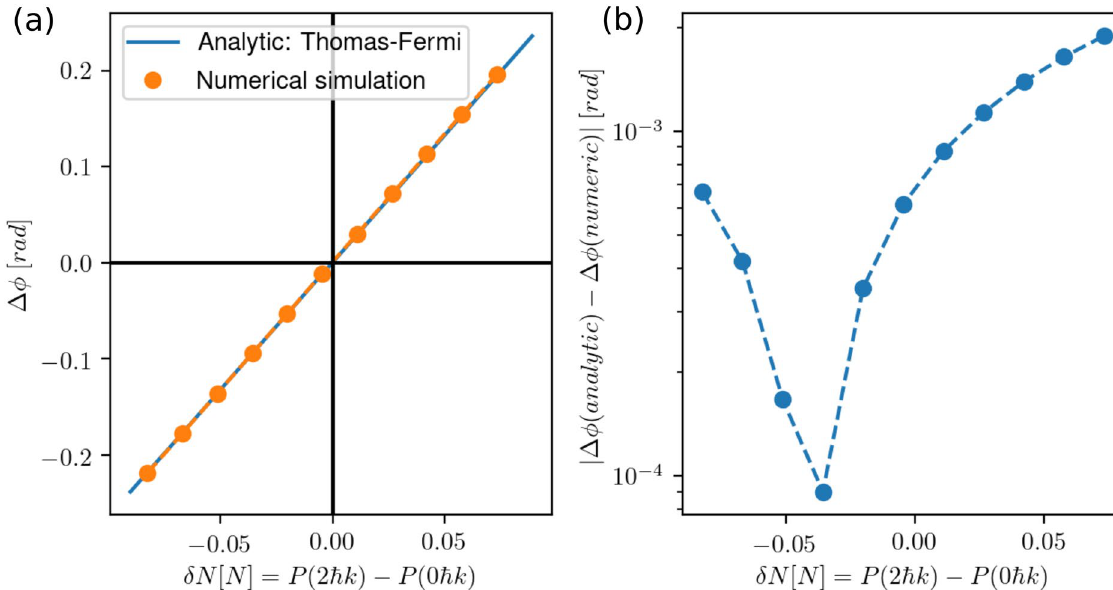
Figure 6. ( a ) Mean-field-driven phase shifts as a function of the particle imbalance δ N . The analytic solution is given by Eq. (24) (blue line). For the numerical solution (orange dots), we modeled the imbalance by considering a first π 2 beam-splitter with a finite fidelity. The Gaussian splitter and mirror pulses have peak Rabi 50 µ s, respectively. The transverse 1.0573 ω 25 µ s and τ frequencies of (cid:31) r with pulse lengths of τ bs = m = = 50 Hz and the initial trap frequency in which trapping frequency is realised with an angular frequency of 2 π × 1 Hz with a number of atoms of N 6 10 4 and a scattering length of the BEC is condensed is set to 2 π × = · a s a 0 with a 0 being the Bohr radius. ( b ) Absolute value of the phase difference between the analytic solution = and the numerical simulation. Discrepencies with respect to the analytical model stem from the assumptions of the Thomas–Fermi approximation being not satisfied here (see main